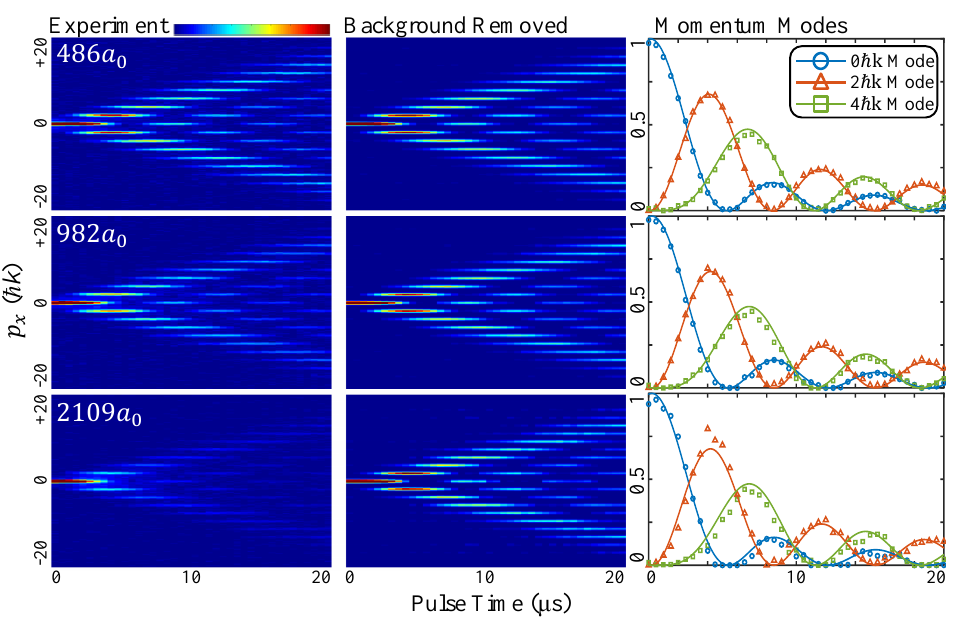
= 500 E at different interaction r 0 are plotted, together with the cor- dd